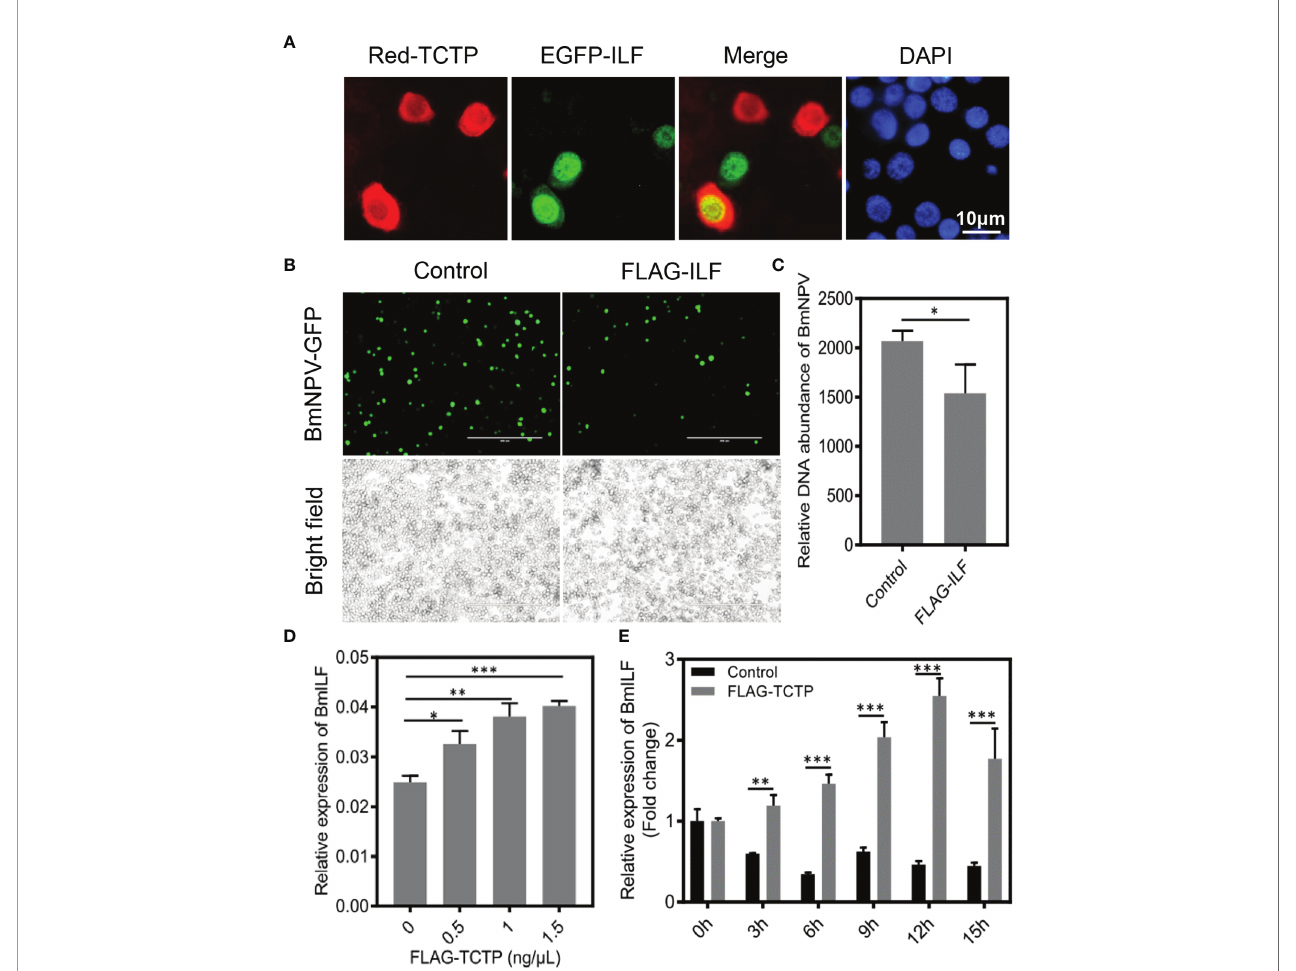
FIGURE 7 | Bombyx mori translationally controlled tumor protein ( BmTCTP ) regulated Bombyx mori interleukin enhancer binding factor ( BmILF ) expression and inhibited viral replication. (A) Plasmids encoding Red-TCTP and EGFP-ILF were co-transfected into the BmN cells. After 3 days of transfection, cells were fi xed and stained with 4 ’ ,6-diamidino-2-phenylindole (DAPI) (blue). Scale bar, 10 m m. (B) Plasmids as indicated were transfected into the BmN cells, and then cells were infected with Bombyx mori nucleopolyhedrovirus (BmNPV)-GFP for 72 h. Fluorescence microscopy was used to observe the viral amounts. Scale bar, 400 m m. (C) The viral DNA contents were detected by qRT-PCR analysis of the BmNPV GP41 gene. The expression of BmGAPDH gene was used as an internal control. The data presented are the means ± SD (n = 3). For the signi fi cant analysis: *P < 0.05. (D) The expression of BmILF gene was analyzed by qRT-PCR in BmTCTP overexpression cells at different concentrations, and the BmeIF-4a was used as an internal control. The data presented are the means ± SD (n = 3). For the signi fi cant analysis: *P < 0.05, **P < 0.01, and ***P < 0.001. (E) The fold changes of BmILF expression was analyzed by qRT-PCR in BmTCTP overexpression cells following the BmNPV infection at the indicated time points, and the BmeIF-4a was used as an internal control. The data presented are the means ± SD (n = 3). For the signi fi cant analysis: **P < 0.01 and ***P <